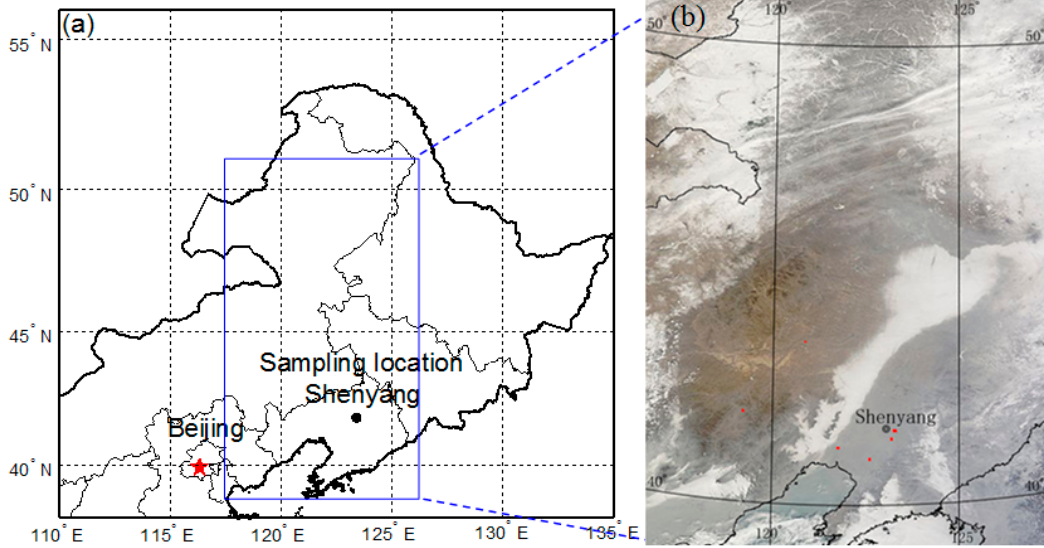
Figure 1. Schematic map of the sampling location ( a ) and a Terra satellite true color image of northeastern China, taken on 25 February 2014 ( b ).